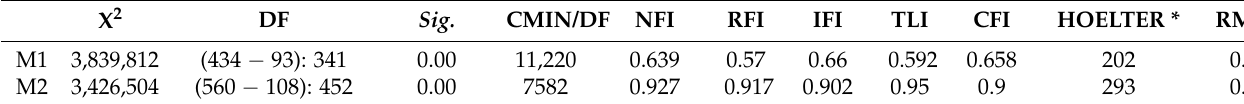
Table 2. Different structural linear models tested.